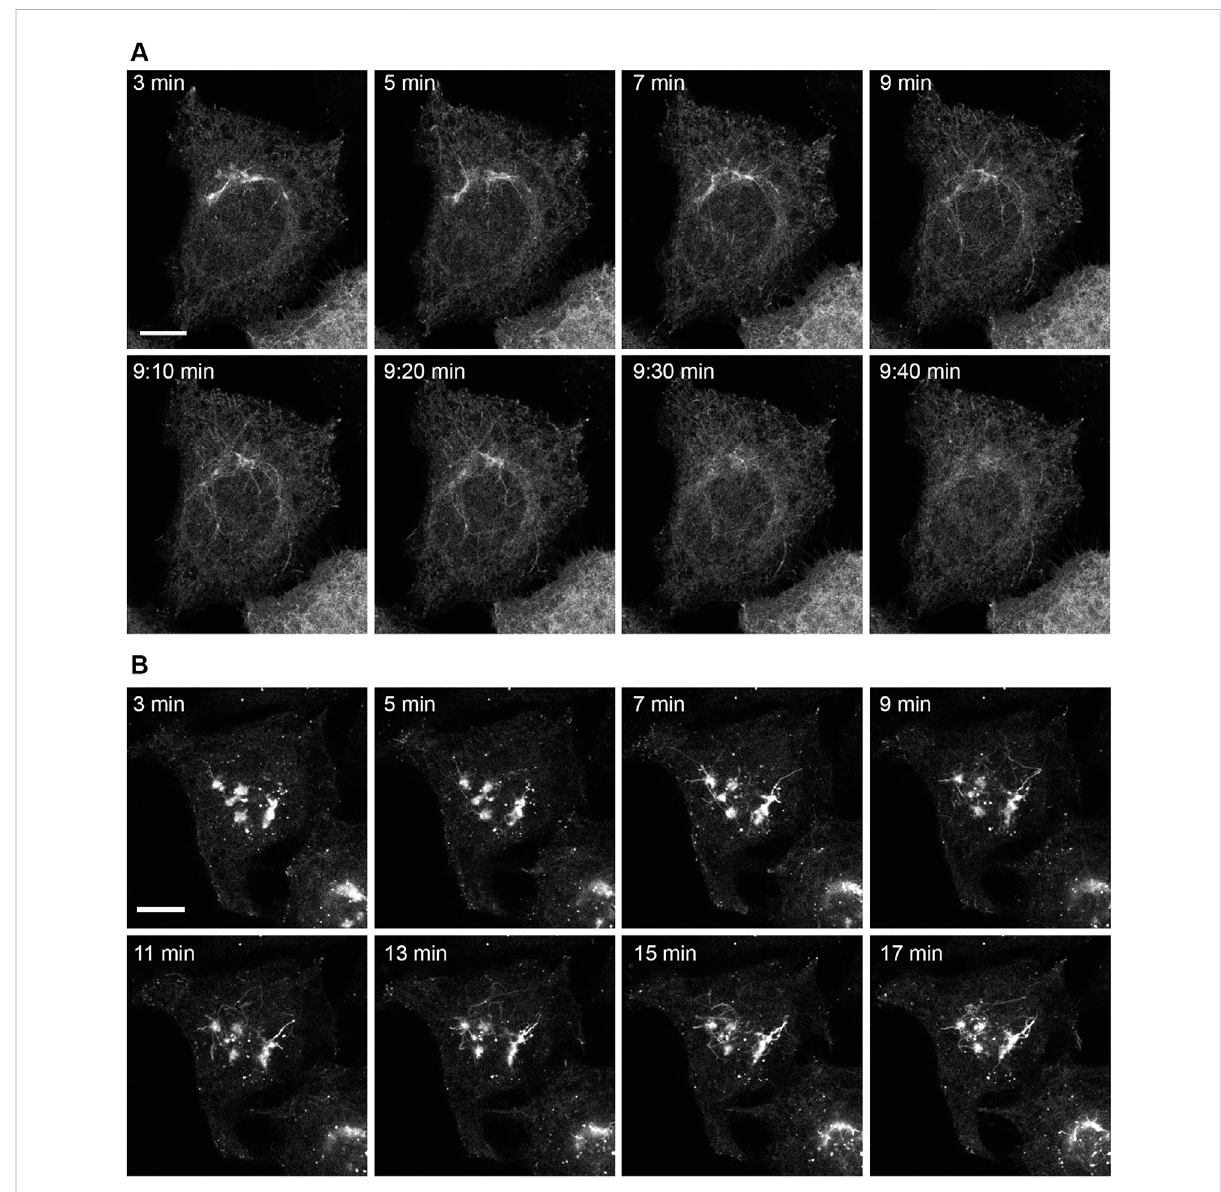
FIGURE 7 Time-lapse imaging of EGFP-Rab6A redistribution after BFA treatment in siSCFD1 treated cells. HeLa Kyoto cells were transfected with siRNAs for48 handEGFP-Rab6A constructs for12 hand treatedwith10 μ g/mlBFA.Confocaltime-lapse imagesweretakenevery 10 s. (A) Example frames from a time-lapse movie in control cells (NEG). The time points refer to the time after BFA addition. (B) Example frames from a time-lapse movie in cells treated with siRNAs against SCFD1. The time points refer to the time after BFA addition. Scale bars: 10